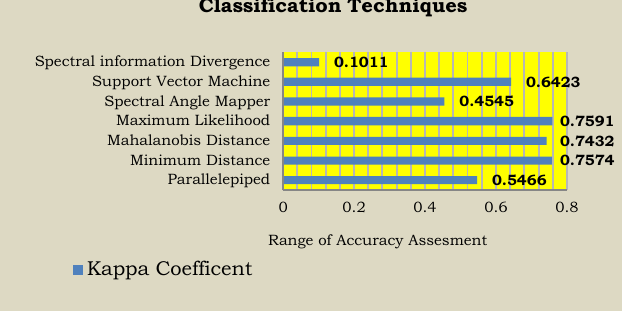
Fig. 15 Comparative barplot of kappa coefficient In the fig. 16 comparative plot of the overall accuracy is shown. Finally, on comparing the obtained accuracy from various classification techniques, we have concluded that MDC technique have obtained maximum accuracy, which is 0.2352 % more than the MLC classification scheme.